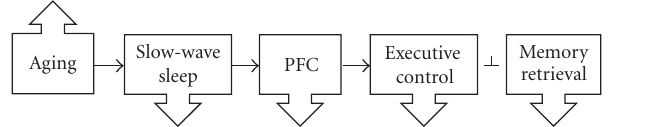
Figure 4: Increasing age leads to decline in slow-wave sleep, and in turn, decreased prefrontal restoration. This decreases executive control abilities, which blocks (perpendicular line) controlled memory